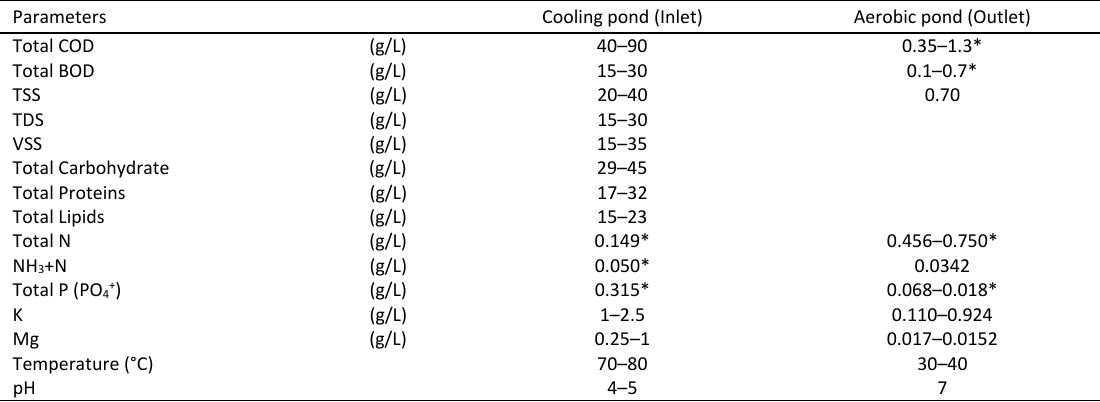
Table 5: POME constituents and conditions (Sasongko et al ., 2014) Parameters